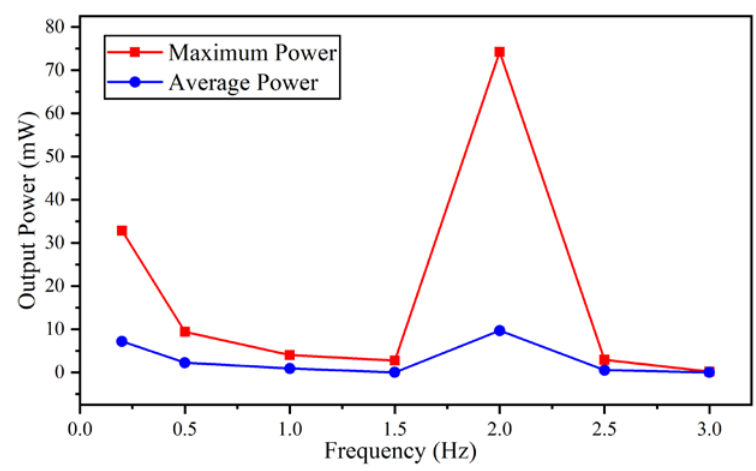
Figure 4. The energy harvester output results under low frequency vibration excitation.